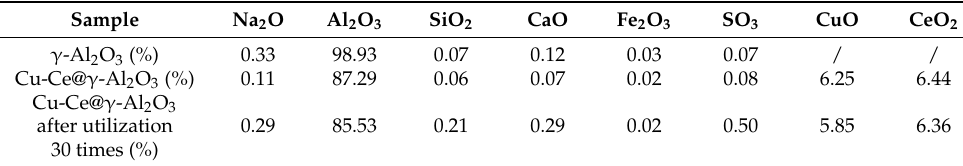
Table 3. XRF characterization of Cu-Ce@ γ -Al 2 O 3 catalyst